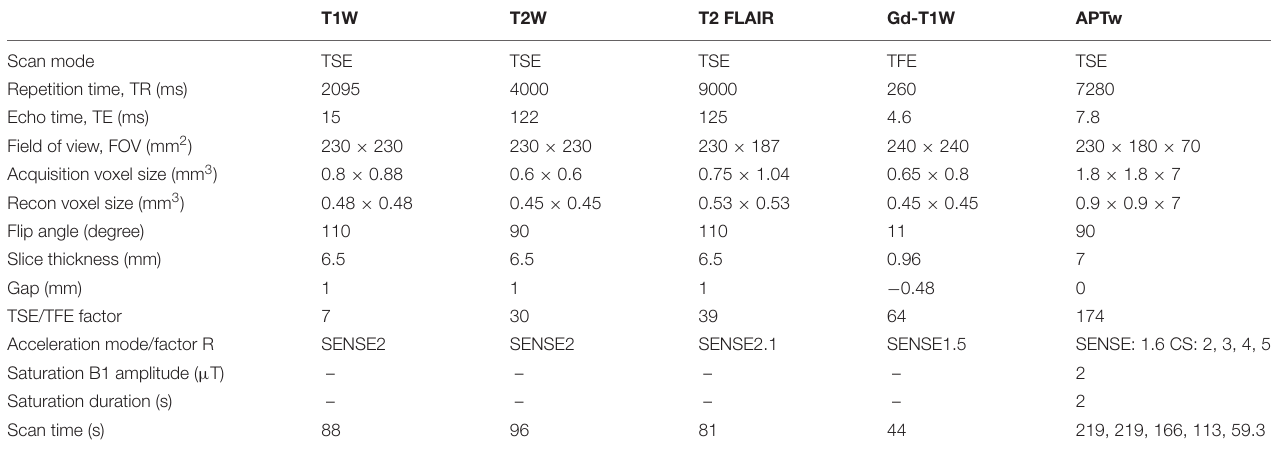
TABLE 1 | Magnetic resonance (MR) parameters of all sequences of brain